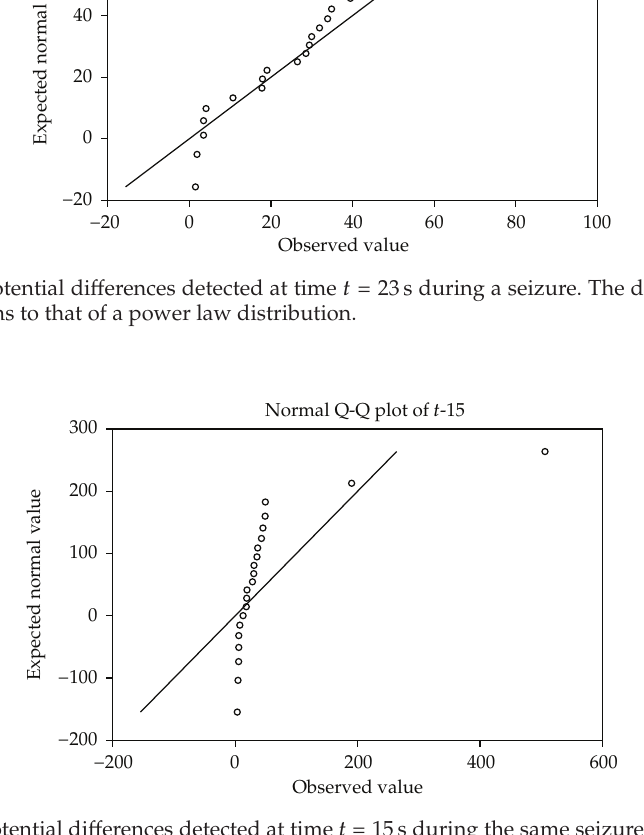
Figure 3: Q-Q of potential di ff erences detected at time t (cid:8) 15s during the same seizure. Note that the data no longer displays normal